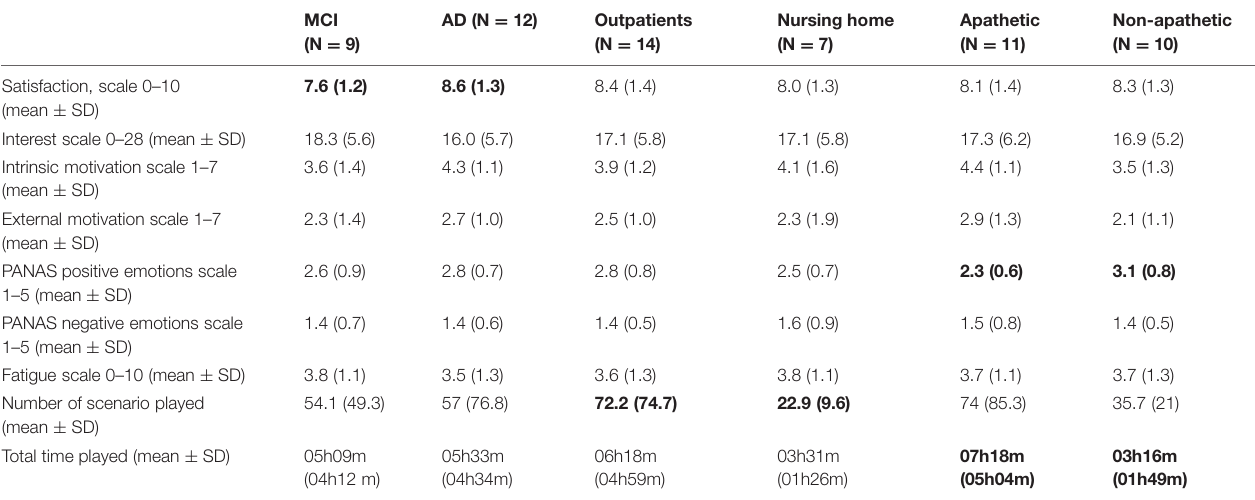
TABLE 2 | Intervention